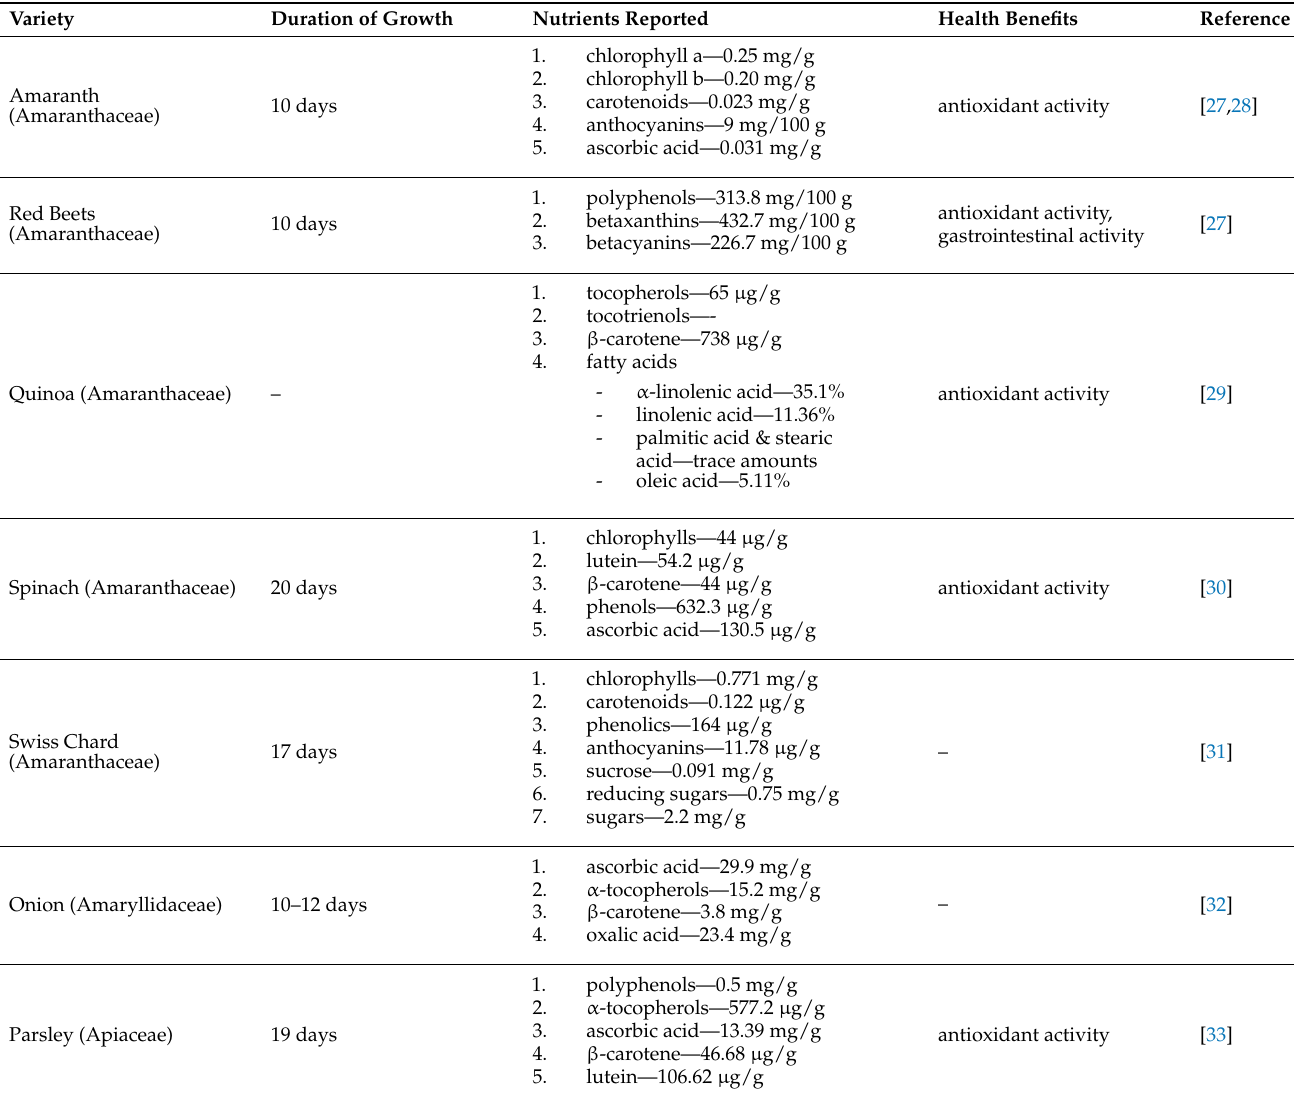
Table 2. Various nutrients and phytochemicals reported in different varieties of microgreen